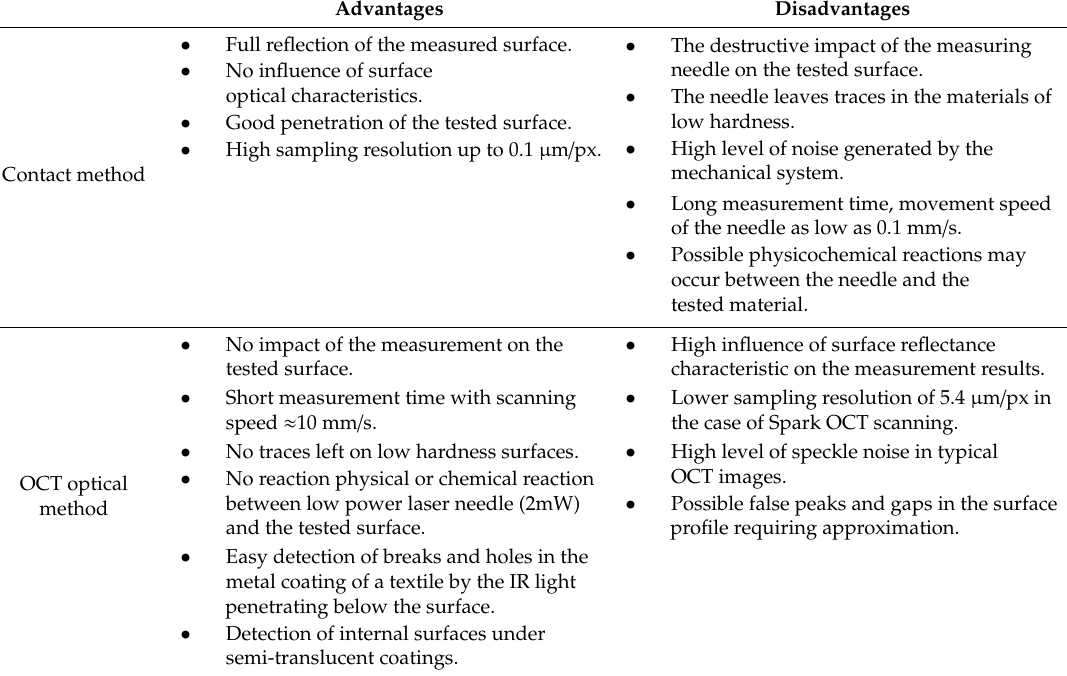
Table 1. Comparison of contact method and optical coherence tomography (OCT)